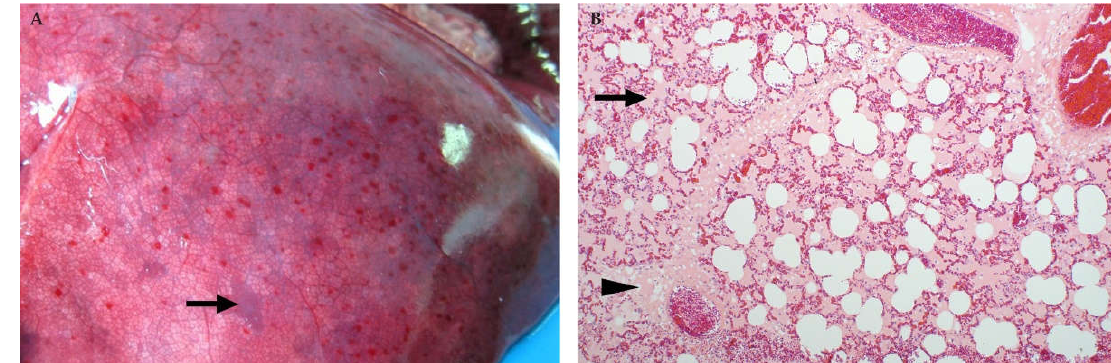
Figure 11. Lungs of RVFV-infected lamb and adult sheep. ( A ) The interstitium in the lungs of this lamb is markedly expanded due to oedema, and dark red areas of atelectasis are present (arrow). Multifocal petechiae are also present in the serosa. ( B ) Microscopically, intra-alveolar (arrow) and interstitial (arrowhead) lung oedema is present in this adult sheep (H&E stain), mag 100×.